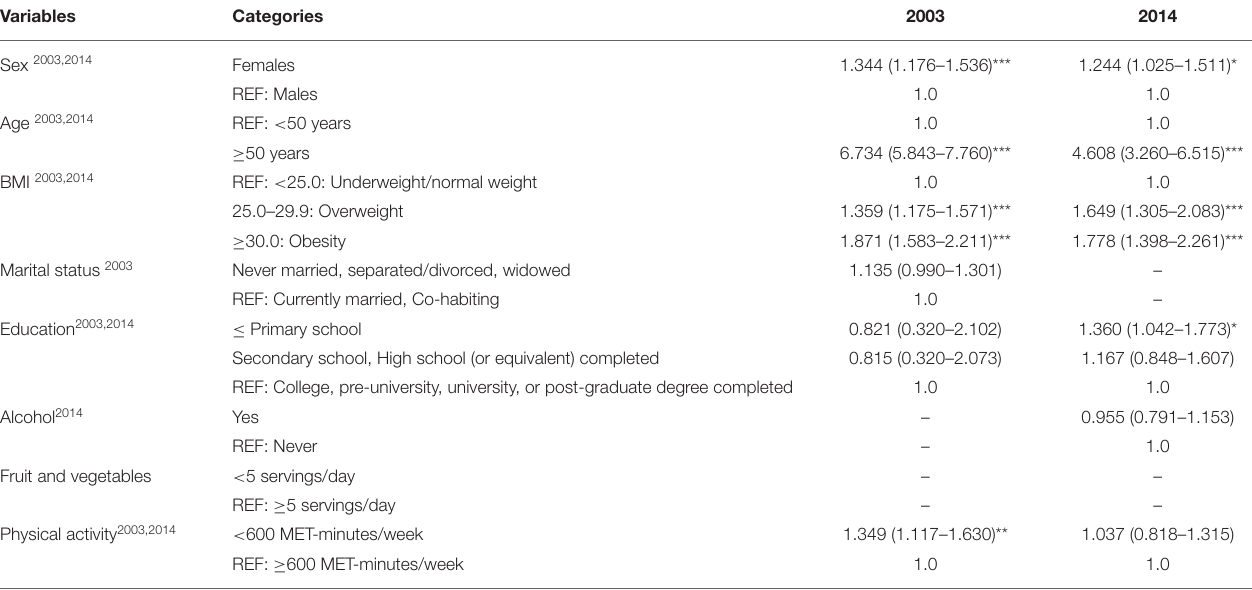
TABLE 2 | Associations between exposure variables and diabetes mellitus (outcome) in Mexican adults, estimated by multivariable logistic regression (by year).